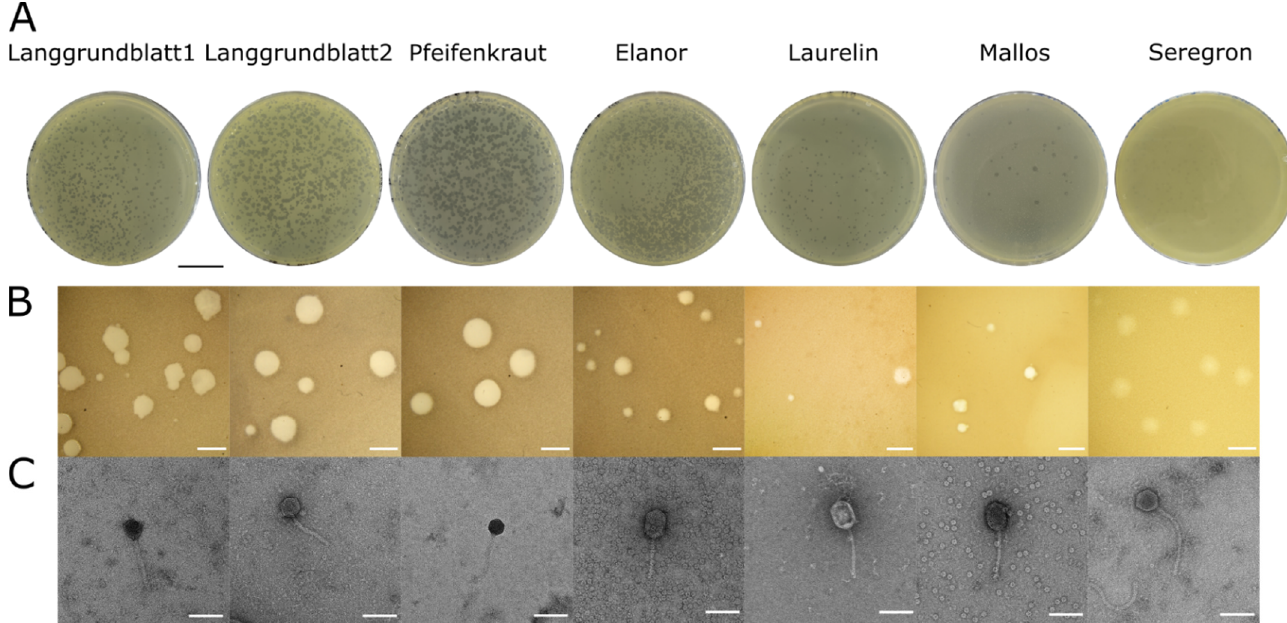
Figure 1. Phage morphology of novel Xanthomonas phage isolates. ( A ) Plaque morphologies of the seven different phages infecting Xanthomonas translucens pv. translucens (DSM 18974) (Langgrund- batt 1, Langgrundbatt 2, Pfeifenkraut, Elanor, Laurelin, and Mallos) and Xanthomonas campestris pv. campestris (Seregon). Scale Bar: 2 cm; ( B ) Stereo microscopy of single plaques. Scale bar: 1 mm; ( C ) Transmission electron microscopy (TEM) images of virion particles. The phage isolates were negative stained with uranyl acetate. Scale bar: 100 nm.